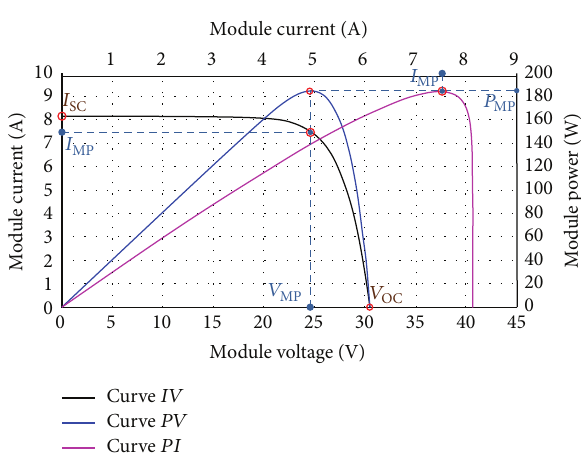
Figure 3: Characteristic curves of a photovoltaic